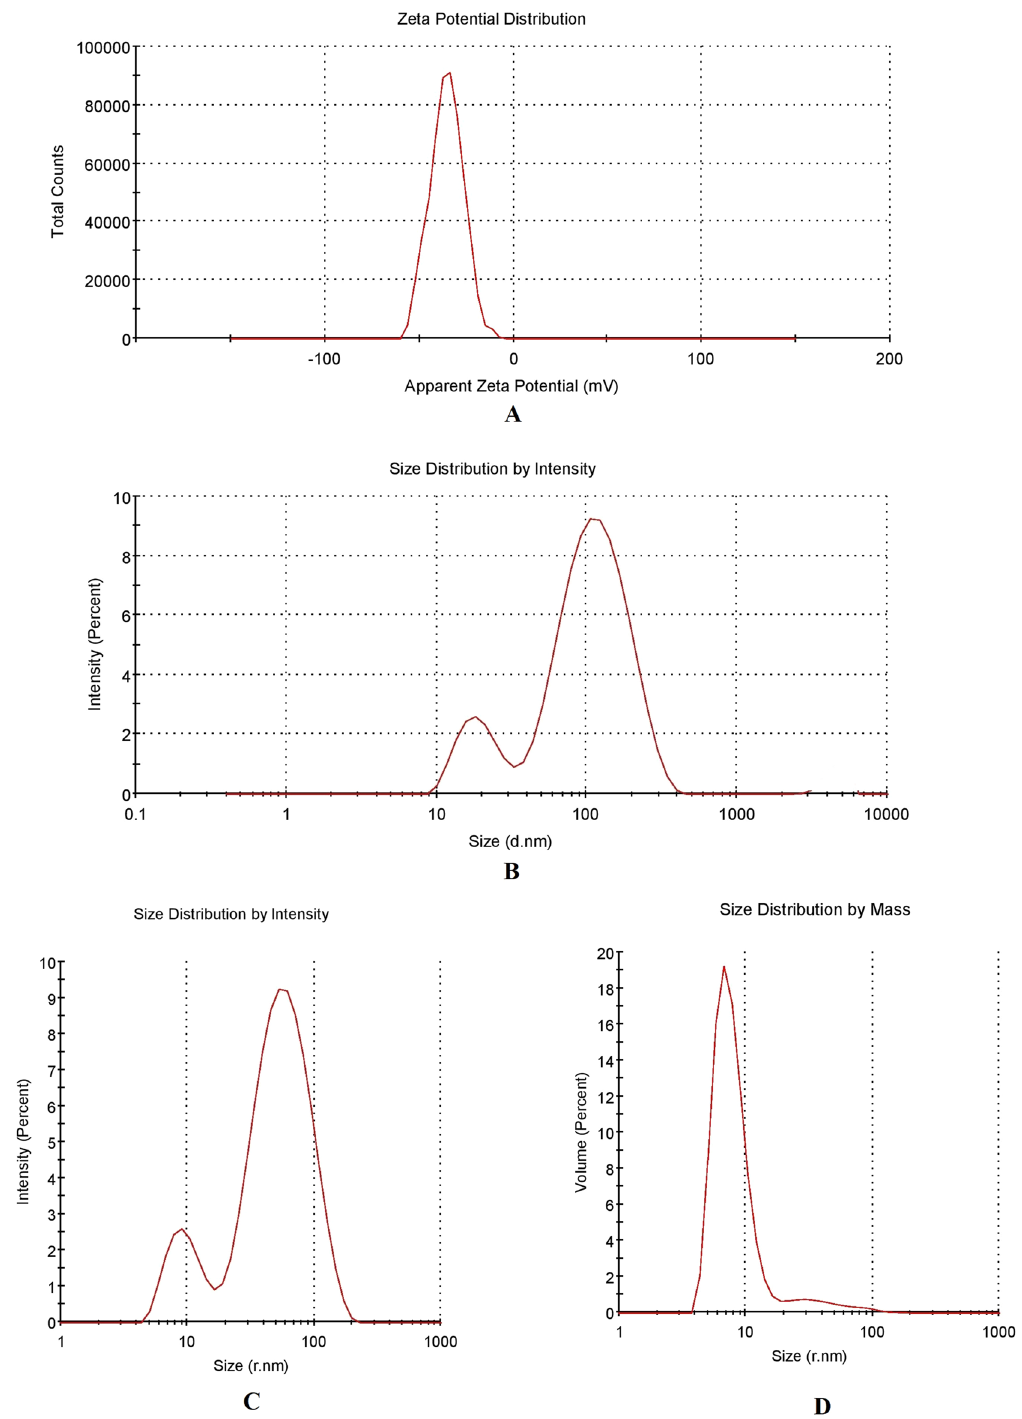
Figure 2. Physical characterization of 1% w/v of dextran sulfate sodium (DSS) nanoparticles of batch 3. ( A ) Zetapotential graph of DSS nanoparticle. ( B ) Nano size (z d nm) distribution of DSS nanoparticles through particle intensity. ( C ) Size (r nm) distribution by intensity analysis of DSS nanoparticles. ( D ) Size (r nm) distribution analysis by